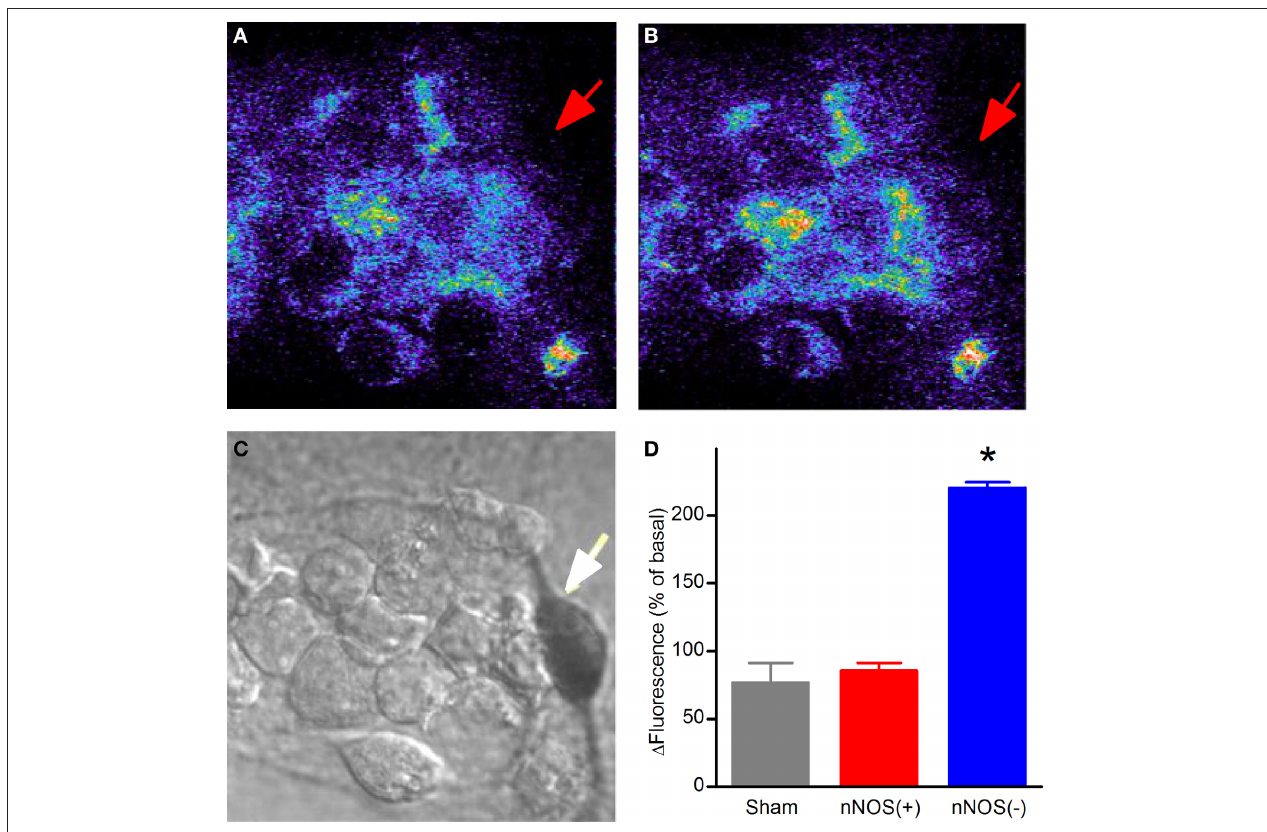
FIGURE 3 | NMDAR-dependentmitochondrial ROS production in striatal cultured neurons. (A) Confocal images of basal levels of fluorescence of DHR-loaded neurons prior to NMDA stimulation. (B) DHR fluorescence 25min after a 5min NMDA exposure. (C) Bright field image showing stained